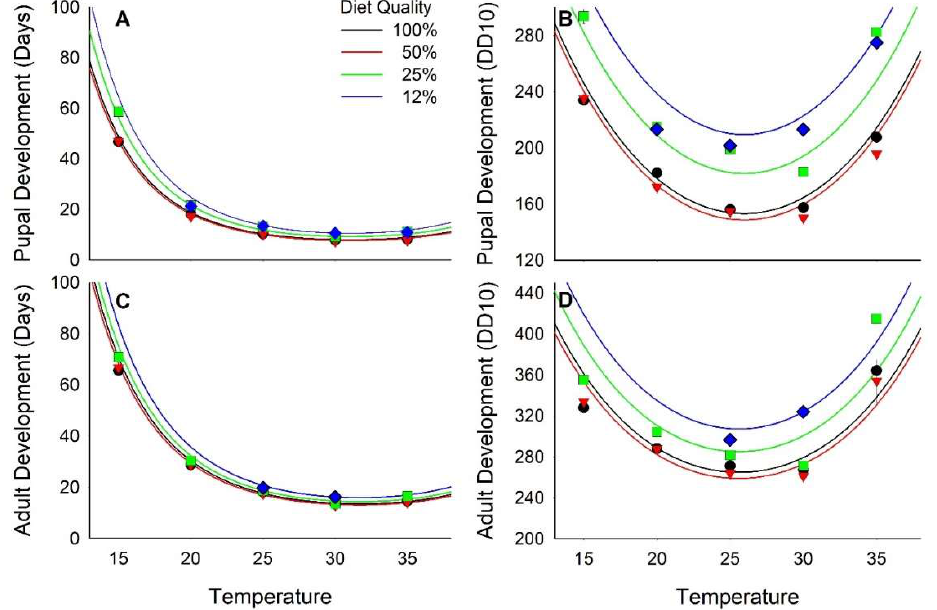
Figure 1. Effect of diet quality and temperature on development time. ( A ) and ( B ) are time to pupariation; ( C ) and ( D ) are time to adult emergence. ( A ) and ( C ) are in units of days; ( B ) and ( D ) are in units of Degree Days 10 . Lines are regression equations and bars are standard errors.